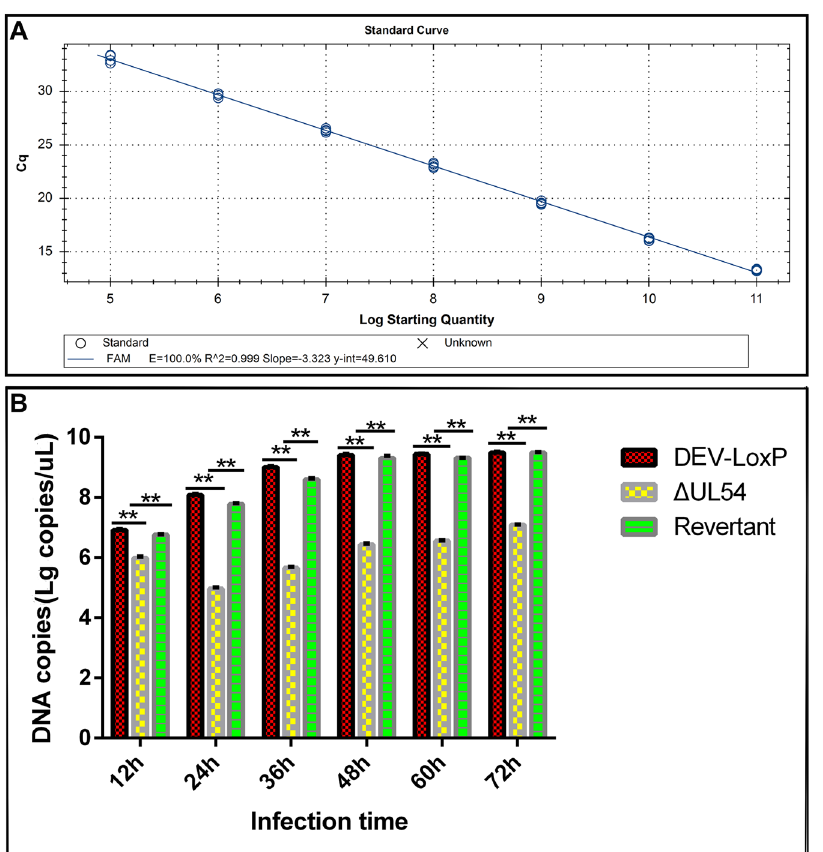
Figure 3. Viral DNA copy number of the DEV-derived viruses. ( A ) Construction of the standard curve. ( B ) Levels of DEV-derived genomic DNA. DEFs were infected with DEV-LoxP, DEV- Δ UL54 or DEV- Δ UL54 (Revertant) at 200 TCID 50 . At different time points, total viral DNA was purified, and quantitative PCR was performed. ** p <